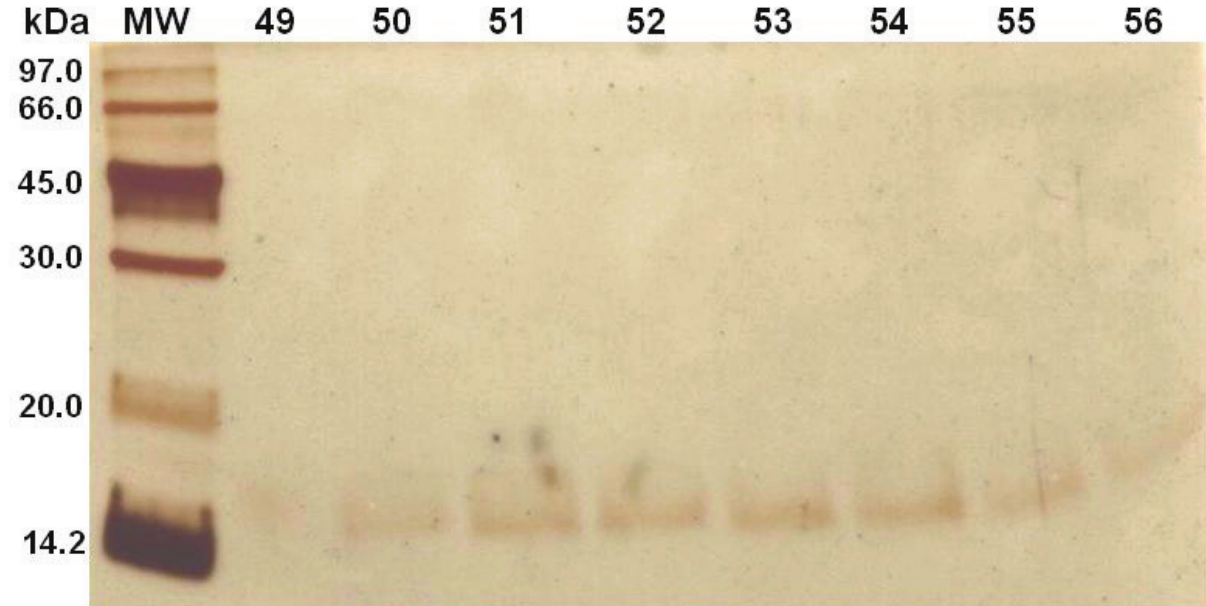
Figure 6 . SDS-PAGE of fractions from peak II (Figure 4) obtained in the gel filtration chromatography of the ATPS bottom phase on Sephadex G-75. Numbers at the top of the line indicate the fraction eluted from the chromatographic column.